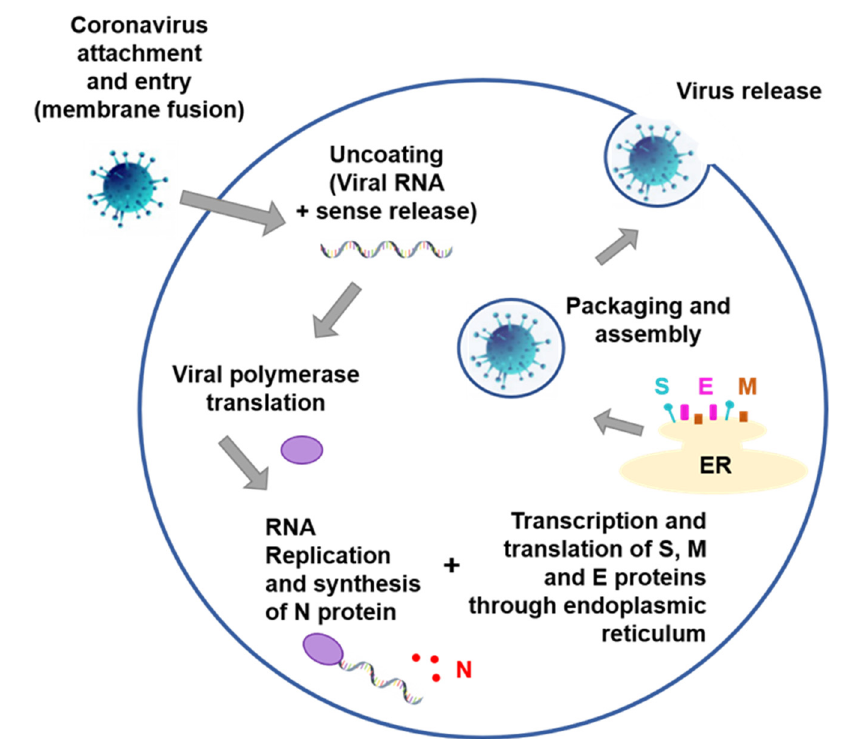
Figure 1. General human pathogenic coronavirus replication. Attachment and entry through S protein binding to specific host receptor. Positive sense viral RNA released and polymerase is translated. Viral RNA is replicated and nucleocapsid (N) structural protein is synthesized in the cytoplasm, and S protein, membrane (M) and envelope (E) are transcribed/translated in the endoplasmic reticulum (ER) and transported to the Golgi. Viral components are packed and assembly in a mature virion structure that is then released [4,24].